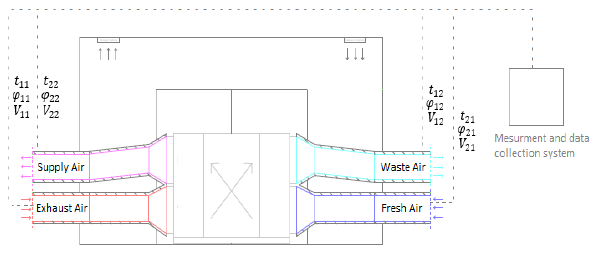
Fig. 1. Diagram of the test